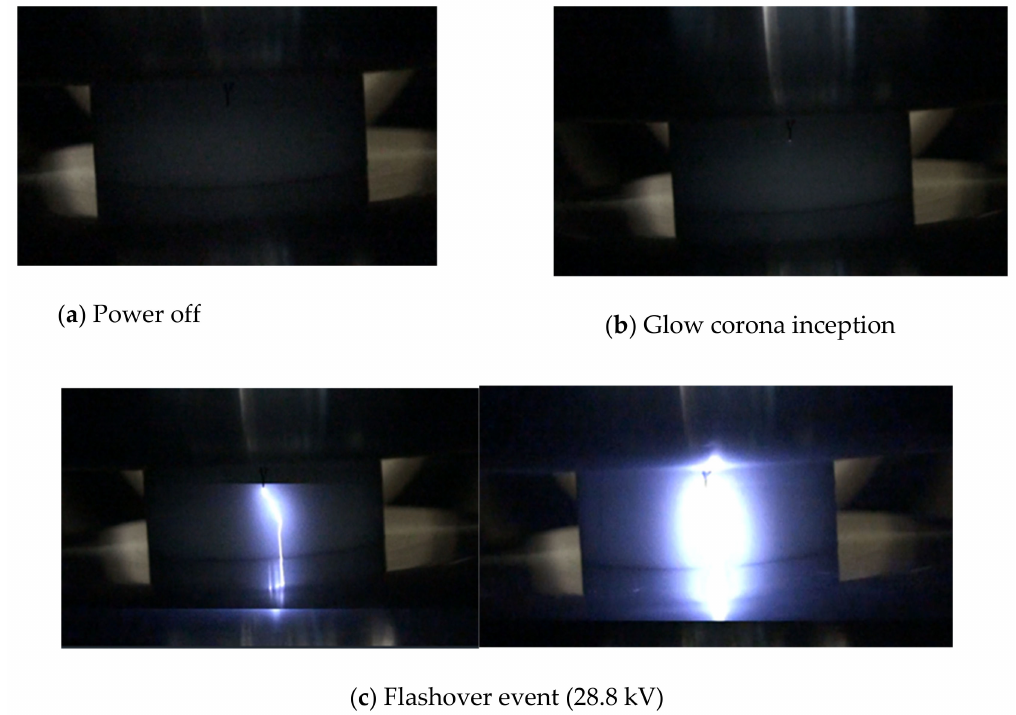
Figure 19. AC (kV peak) flashover voltage for CO 2 (PTFE at 2 bar abs) as a function of applied voltage.